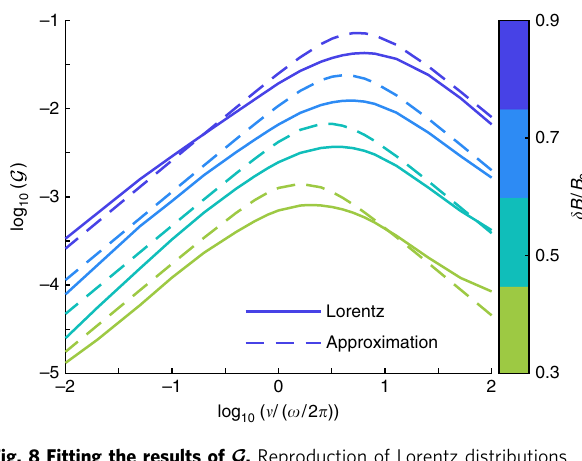
Fig. 8 Fitting the results of G . Reproduction of Lorentz distributions generated in Fig. 4 along with the results from the approximate form of